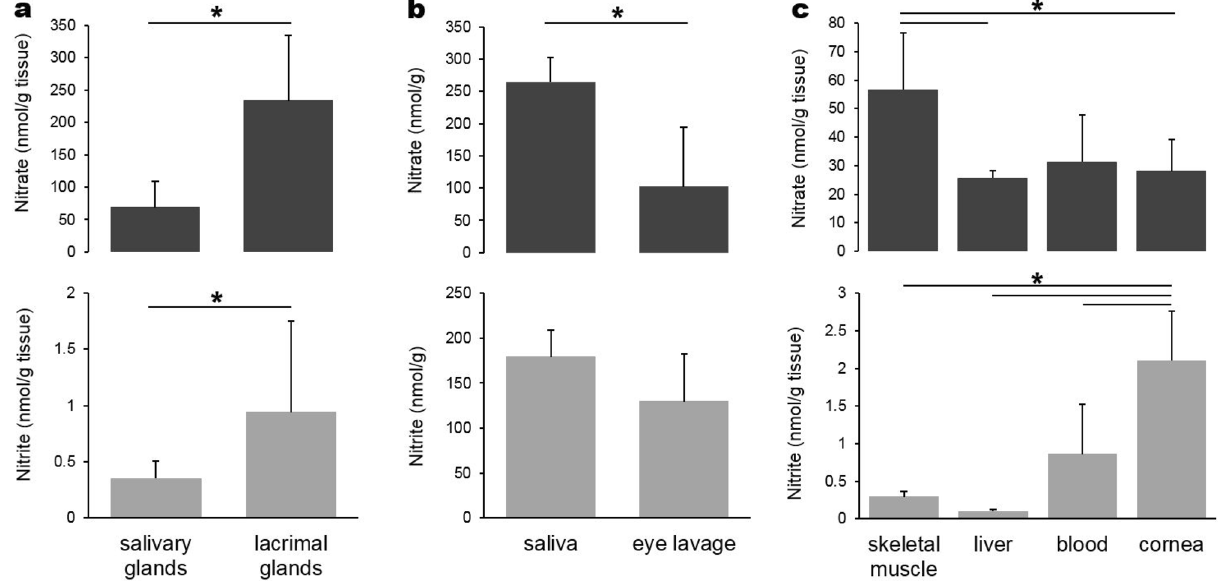
Figure 2. Measurement of nitrate and nitrite levels in porcine tissues. Salivary (combination of parotid, submandibular and sublingual glands) and lacrimal glands ( a ), saliva and eye lavage ( b ) and other internal tissues and cornea ( c ) were analyzed for nitrate and nitrite contents using a standard chemiluminescence method with vanadium chloride or tri-iodide solution respectively, n = 4–17 in each tissue (* p < 0.05).